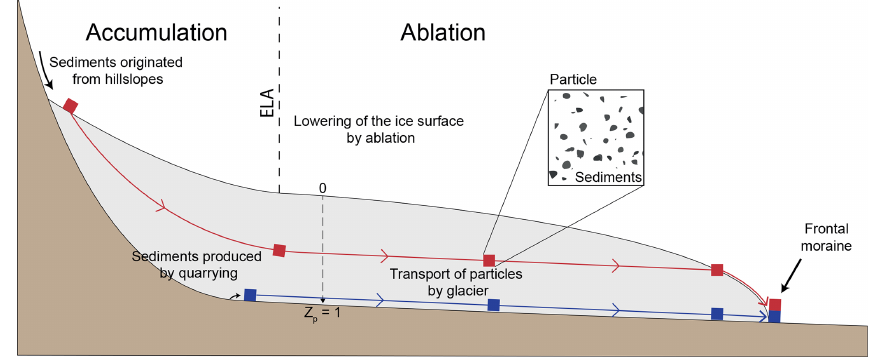
Figure 1. Particle transport by ice. Particles originating from hillslopes enter the glacier system from the surface ( z p = 0), whereas particles produced by ice erosion are incorporated into the basal ice ( z p = 1). The transport of glaciated particles follows the ice flow pattern from the sources to the frontal moraine. ELA is the equilibrium line altitude.